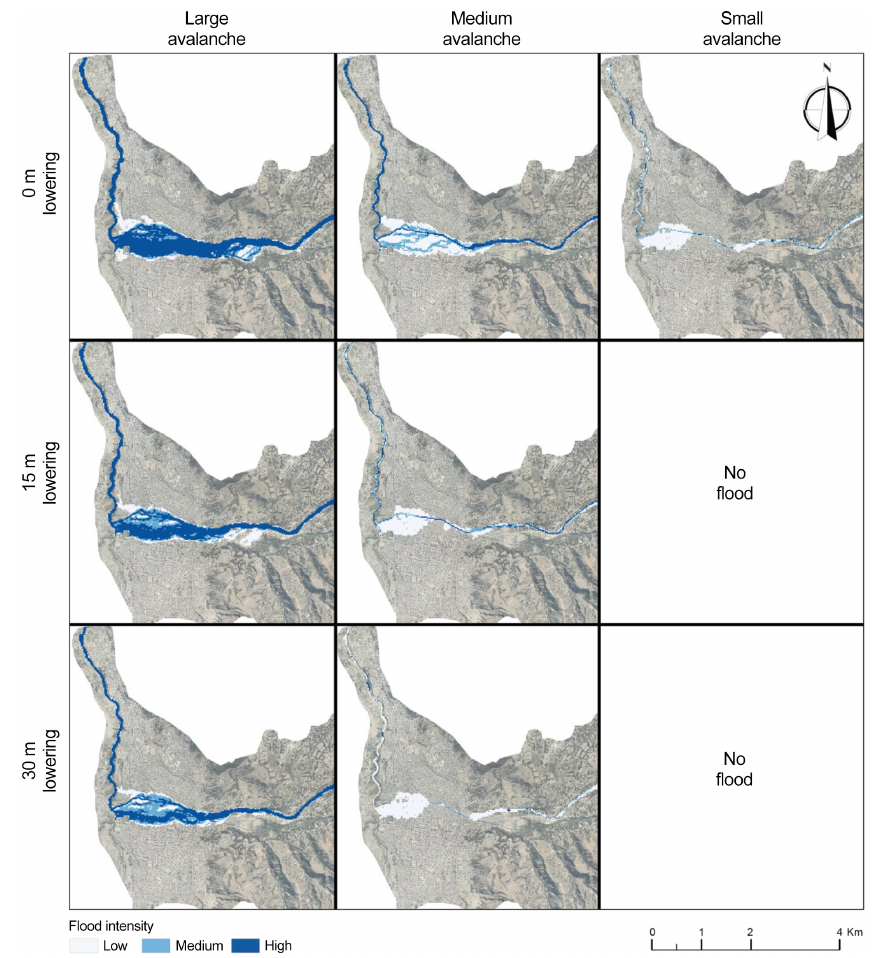
Figure 8. Flood intensity in Huaraz associated with a potential GLOF from Lake Palcacocha for scenarios of 0m of lake lowering (current condition), 15m lowering and 30m lowering conditions for small, medium and large